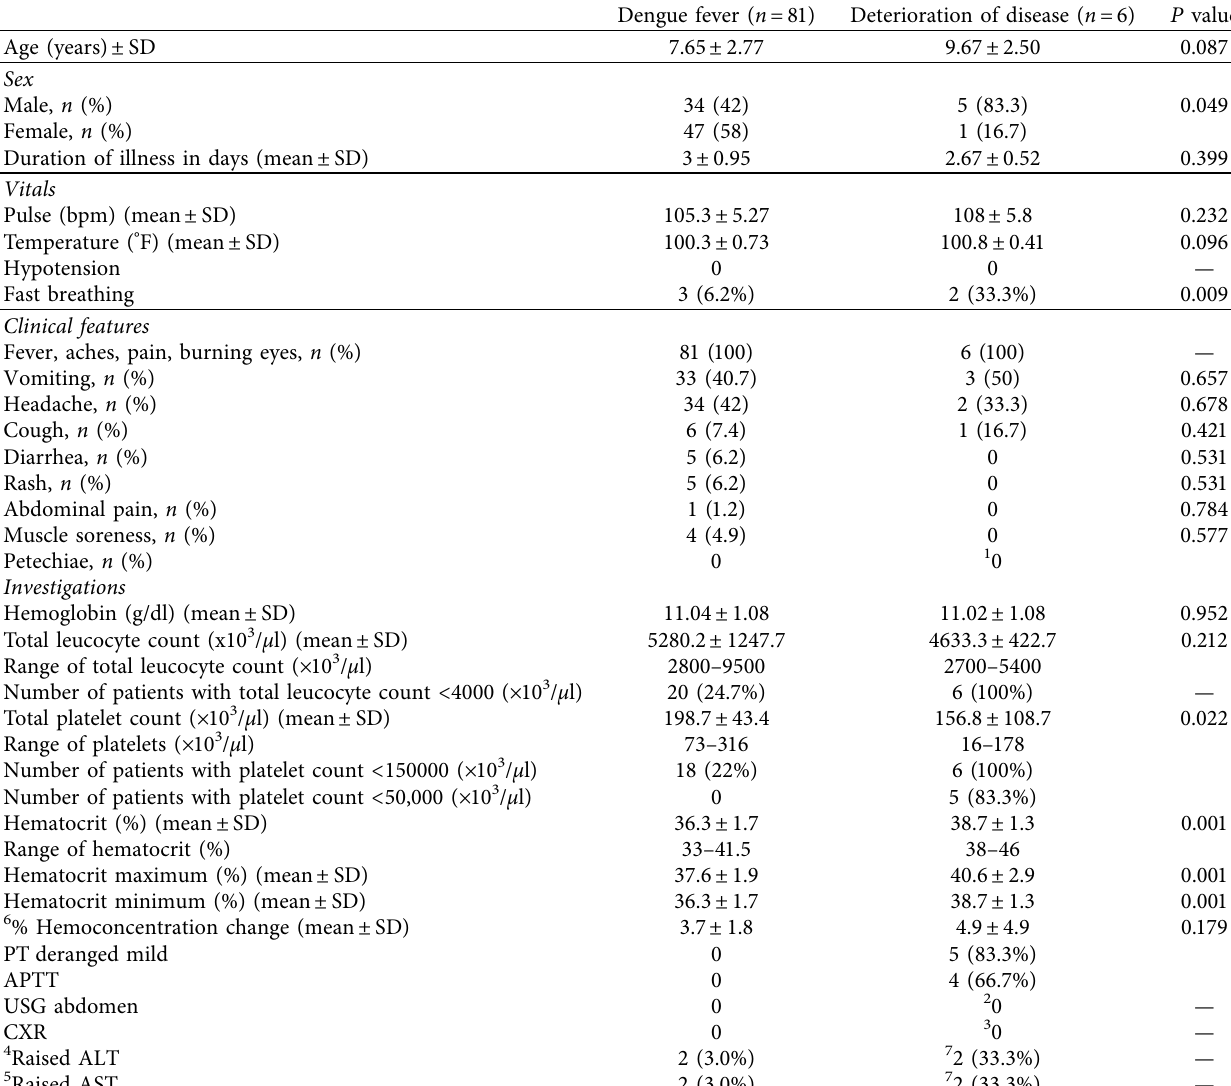
Table 4: Comparison of baseline characteristics of patients with dengue fever who remained stable with the patients who had deterioration of disease on